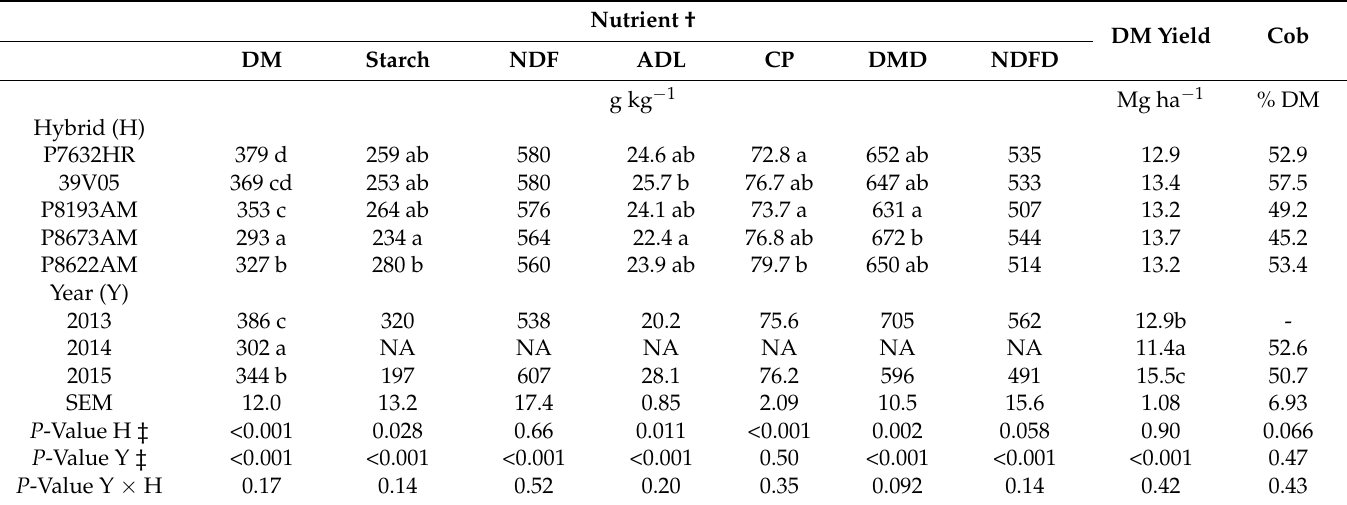
† ADL, acid detergent lignin; CP, crude protein; DM, dry matter; DMD, 48 hours dry matter digestibility; NA, samples were not available for analysis due to drying problems; NDF, neutral detergent fiber, all concentration of DM; NDFD, 48 hours neutral detergent fiber digestibility as concentration of NDF. ‡ Within columns, means followed by the same letter (a, b, c, d) are not significantly different among hybrids or years ( p <